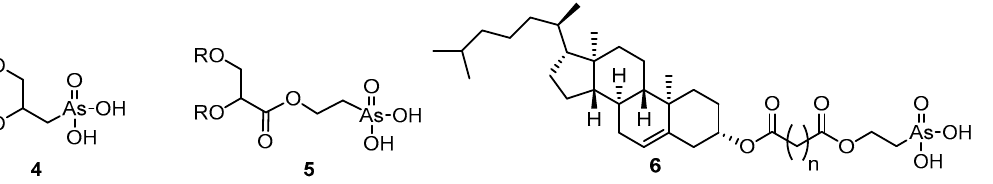
Figure 2. Structures of the targeted arsono-containing lipids.